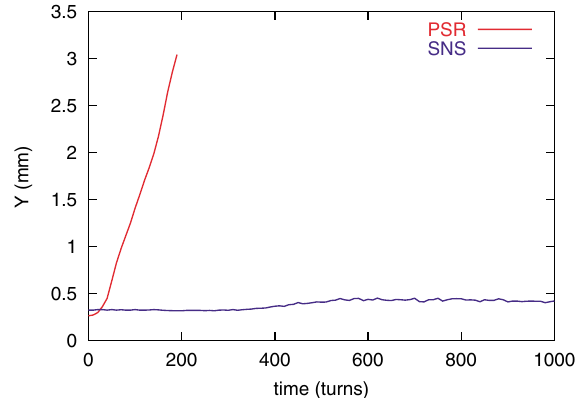
FIG. 22. (Color) Instantaneous current and dipole density for the 200th turn of PSR simulation using parameters in Table II.